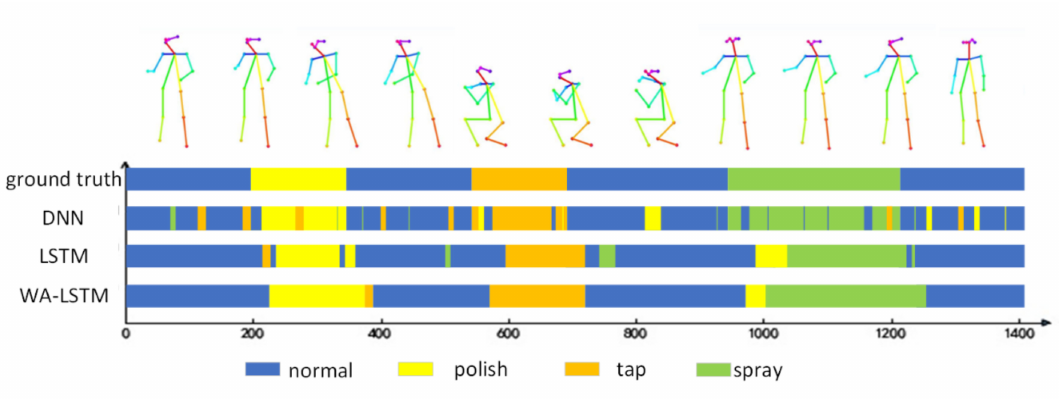
Figure 7. The predicted results of each model and the truth label are stacked along the time axis, which can reflect the detection results of each